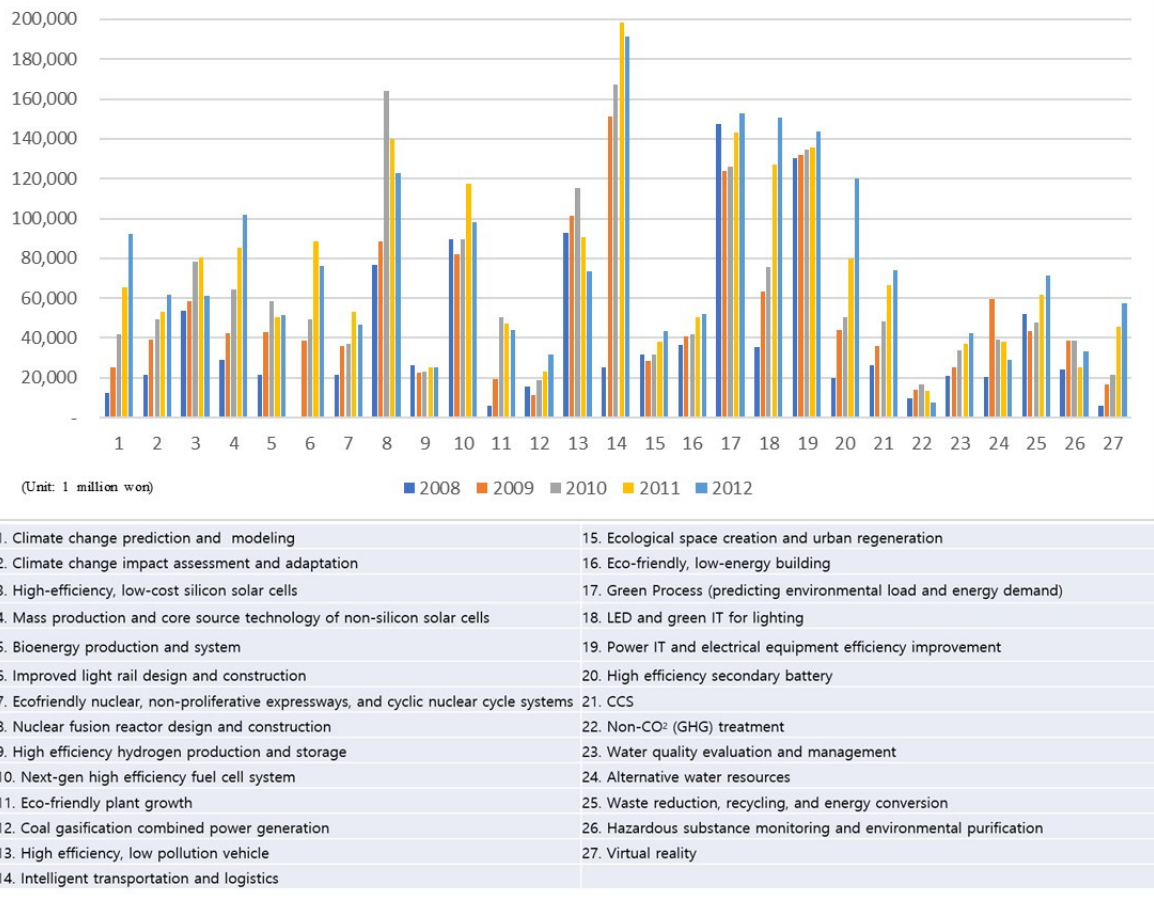
Figure 3. Investment trend of 27 Green Technologies from 2008 to 2012 (data from Green Technology Center, 2013).